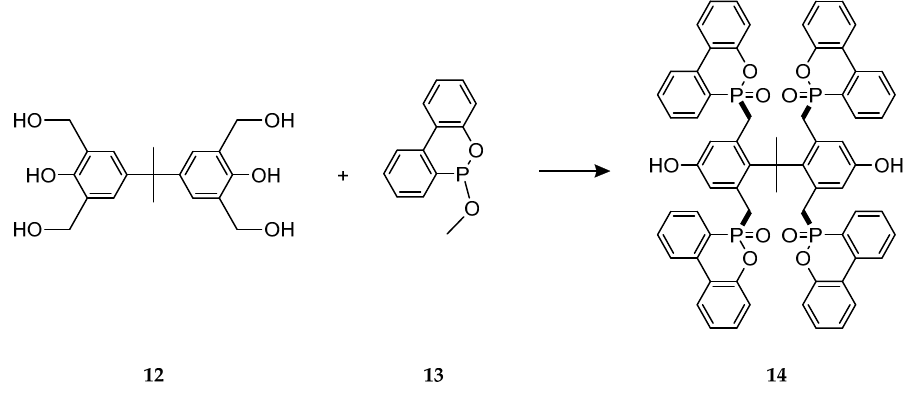
Figure 10. Flame retardant compounds 15 , 16 and 17 . The PMMD copolymers were synthesized from poly(ethylene glycol), methacrylate, methyl methacrylate and monomer 15 in different molar ratios 1:6:2 (PMMD-162) and 1:6:3 (PMMD-163). BMMD copolymers were blended with ABS to improve its flame retardancy. Improvements in flame retardancy have been observed using LOI and UL 94 tests. LOI values were 20.8% for 20 wt % PMMD-162 and 20.3% for 20 wt % PMMD-163, while neat ABS showed an LOI value of 17.8%. UL 94 tests also showed better fire results with increased amount of FR. Diethyl bromoethylphosphonate ( 16 , Figure 10) has been synthesized from 1,2-dibromoethane and triethyl phosphite to improve flame resistance of several polymers [68]. Compound 16 was used to synthesize other monomers for ROMP homopolymerization. Dimethyl benzylphosphonate ( 17 )